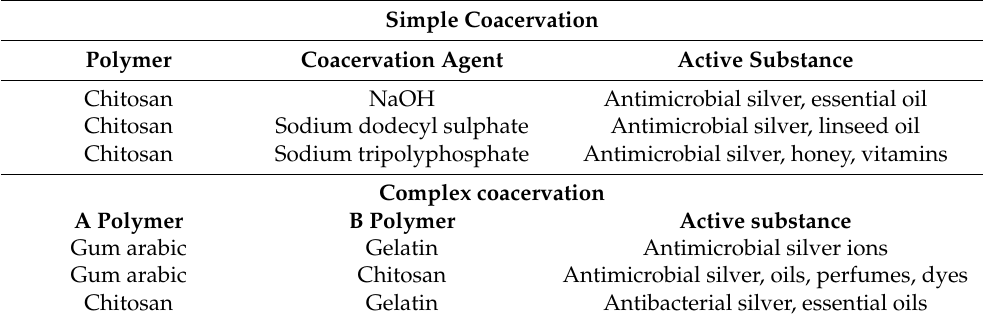
Table 1. Shell and core materials used in simple and complex coacervation for textile